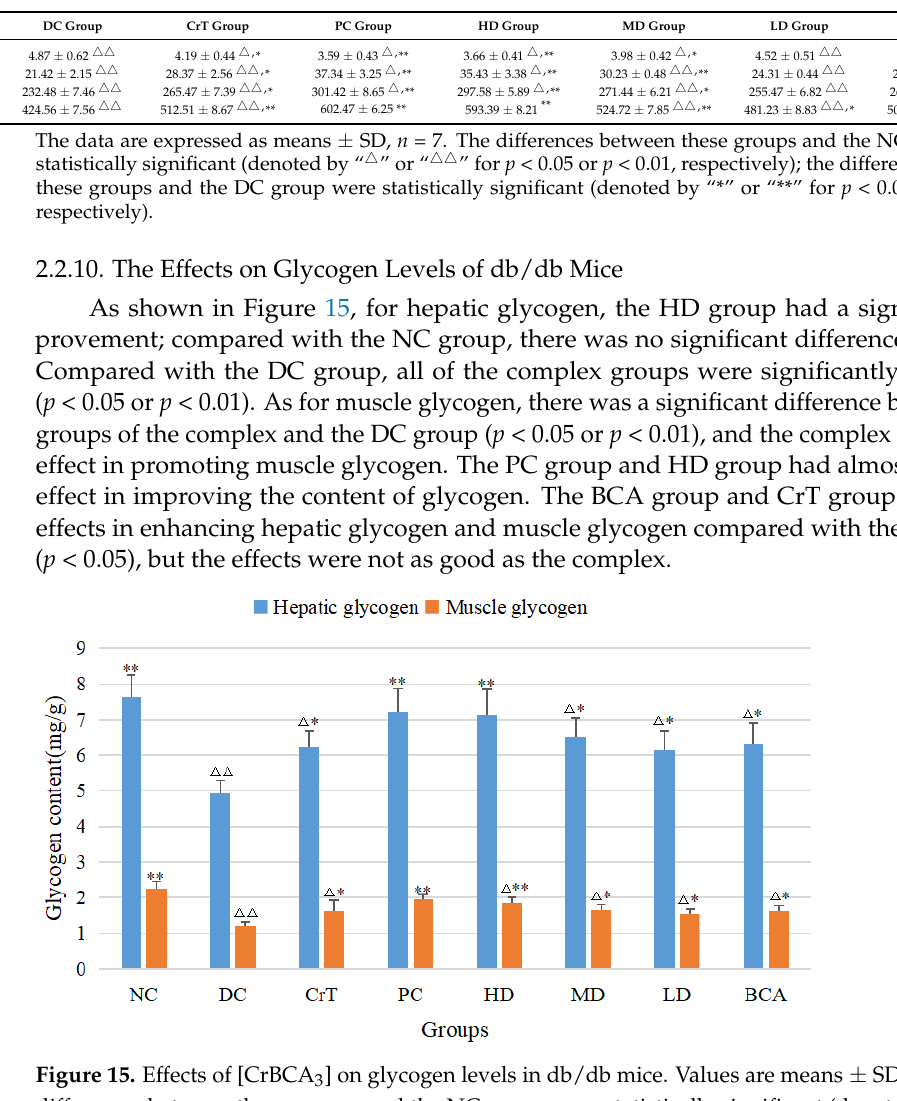
Table 6. The effects on MDA levels and antioxidant enzyme activities in liver of db/db mice.